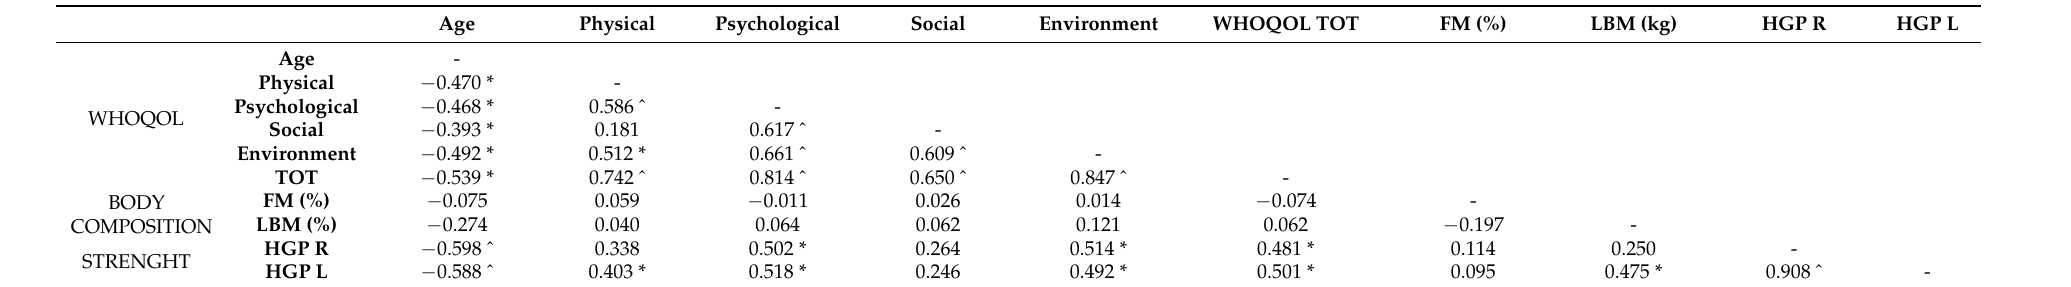
Table 4. Matrix of correlations between different